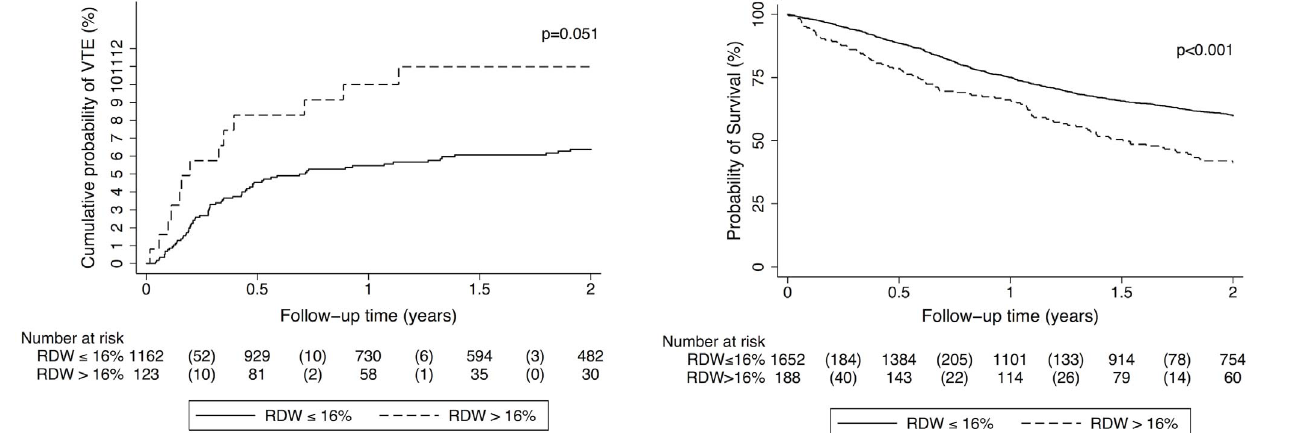
lower erythrocyte count compared to patients with normal RDW levels. Detailed numbers can be found in Table S1. Moreover, patients with RDW . 16% were more frequently taking ESAs and iron supplementary therapy in comparison to patients who had lower RDW levels (ESAs: 20 [10.6%] vs. 34 [2.1%]; p , 0.001;